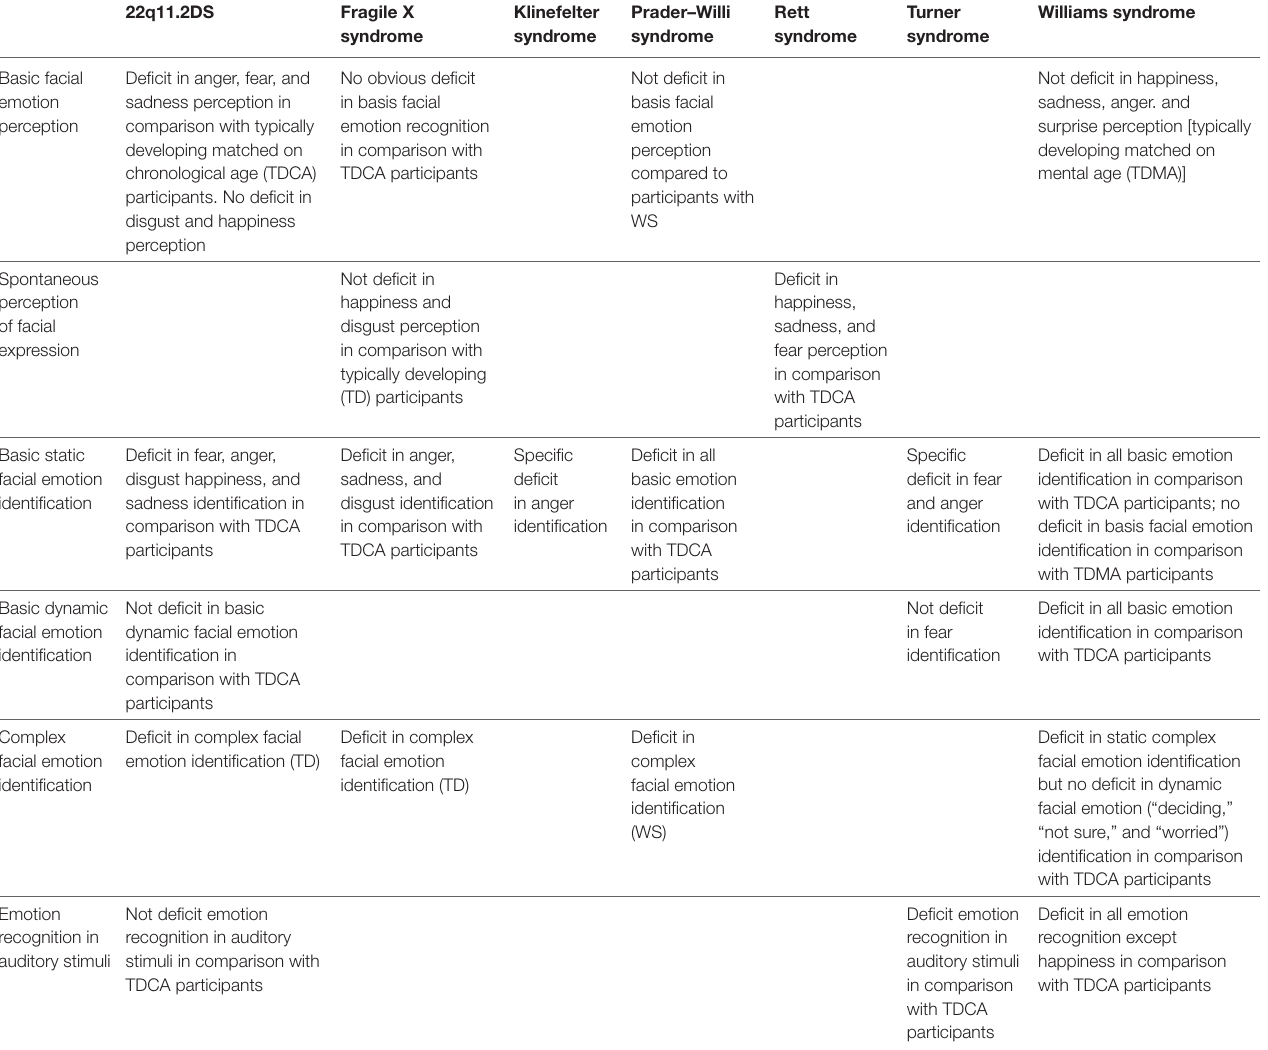
TAbLe 6 | Emotion processing among rare neurodevelopmental syndrome.